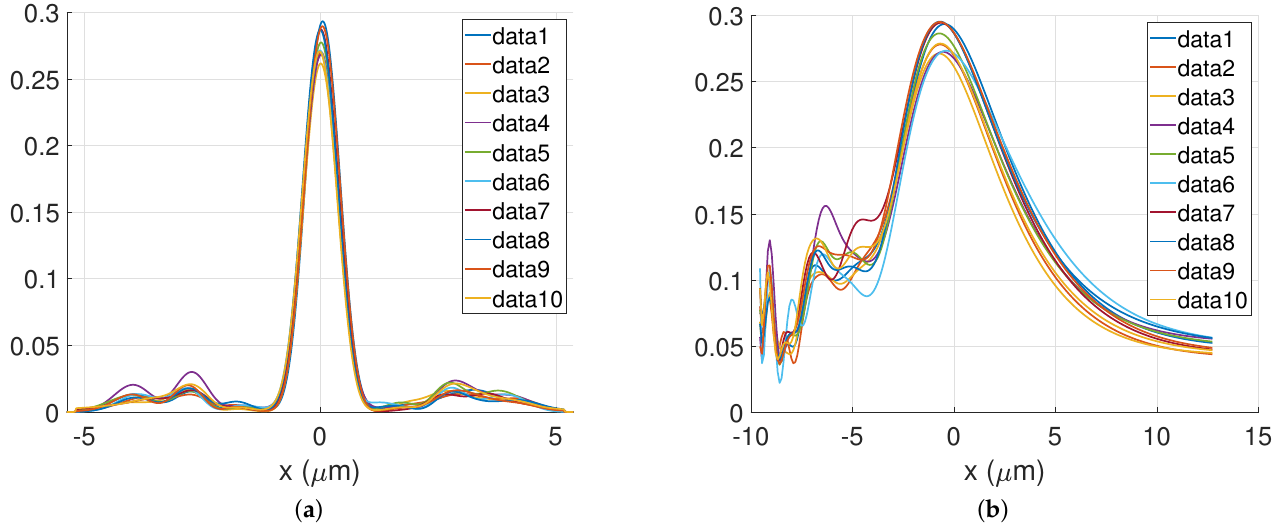
Figure 4. Design of a 10.75 µ m-wide plasmonic metalens consisting of N p = 105 silver-nanoridges and nanoslits focusing a normal incident TM-polarized plane wave at a wavelength λ = 0.637 µ m at a distance of 15 λ . Line scans of the normalized magnetic field intensity in the transverse ( z f = 0) ( a ) and in the longitudinal x = 0 ( b ) focal plane respectively, for ten random realizations of initial conditions. Numerical parameters: λ = 0.637 µ m, N p = 105, h = 400 nm, TM polarization.